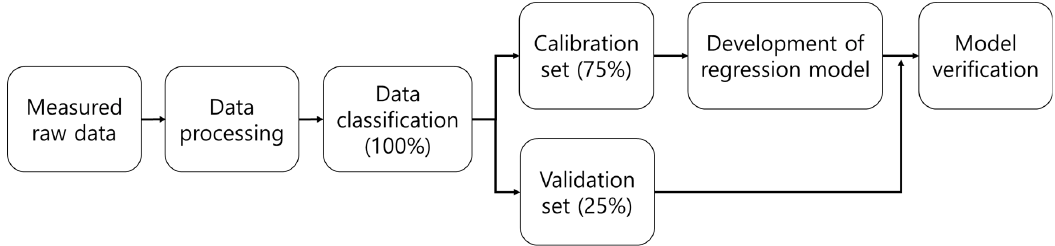
Figure 4. Procedure for the development and verification of the prediction model using regression analysis.